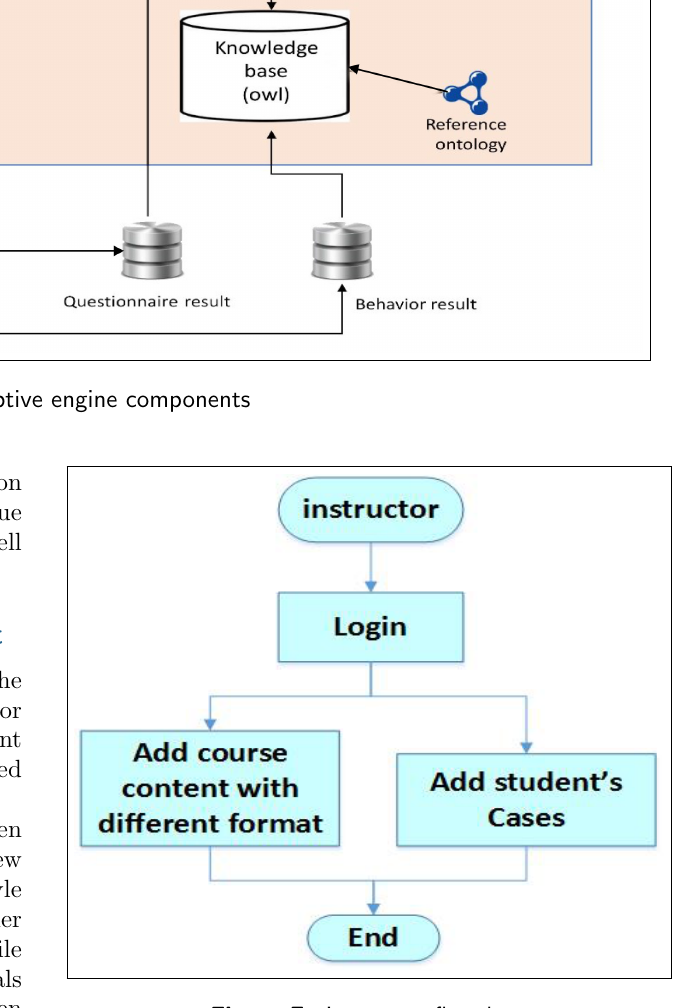
Figure 7. Instructor